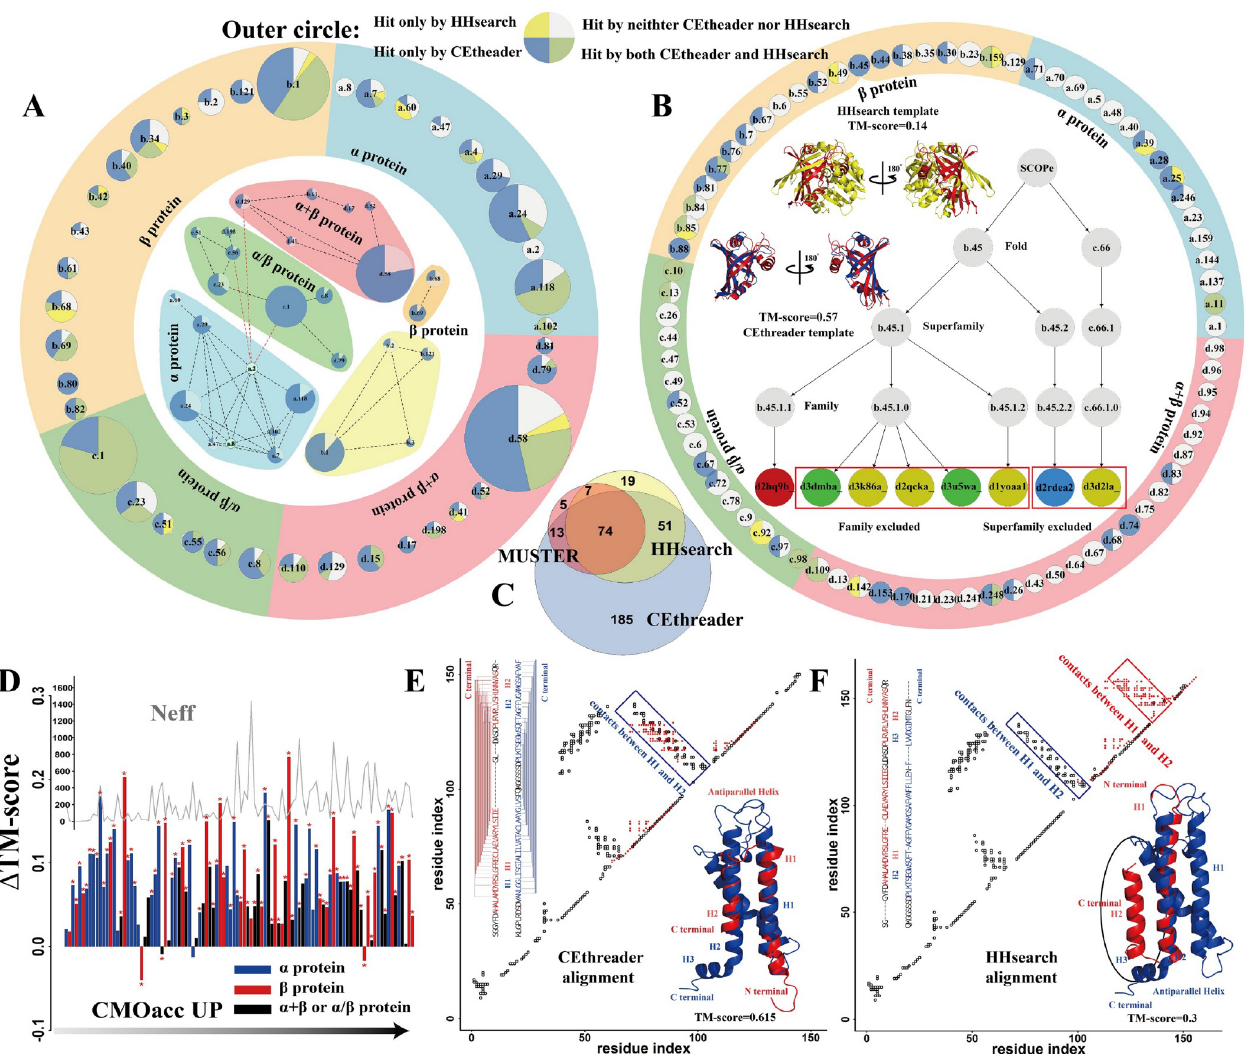
Fig 4. Performance of CEthreader and HHsearch on Benchmark Set-II, which was collected from the SCOPe database. (A) The ability of CEthreader and HHsearch to recognize Folds from 39 large Fold groups with � 4 Superfamilies. The size of a pie chart is proportional to the number of Superfamilies in the Fold group. The area of the sectors of each pie chart in the Outer circle is proportional to the number of correct hits by each different method, while that in the Inner circle represents the portion of Superfamilies hit (blue) or not hit (white) by CEtheader. A dotted line connects two Folds if the average TM-score between them is > 0.4. (B) Same as (A) but for 77 small Fold groups with 2 or 3 Superfamilies. The Inner disc shows a representative example from d2hq9b_ as indicated by the red circle in the SCOPe tree, where the first templates by CEthreader (blue) and HHsearch (yellow) are superimposed on the native (red) separately. (C) Venn diagram for the number of targets with the correct Fold detected by CEthreader, HHsearch, and MUSTER on all 539 Benchmark Set-II proteins. (D) TM-score difference between CEthreader and HHsearch ( Δ TM-score) versus ResPRE contact prediction accuracy (CMOacc) and the number of effective sequences in the MSAs ( Neff ) for 116 Hard targets from (A) and (B). Stars indicate that the TM-score difference between CEthreader and HHsearch is statistically significant as determined by Wilcoxon signed-rank tests. (E, F) Overlay of the predicted contact map and the contact map of the templates identified by CEthreader or HHsearch for the example from d2db7b_. The lower right corner shows the structure superposition of the templates (blue) and the native (red), while the upper left corner shows the query-template alignments with connected lines marking contacts between two